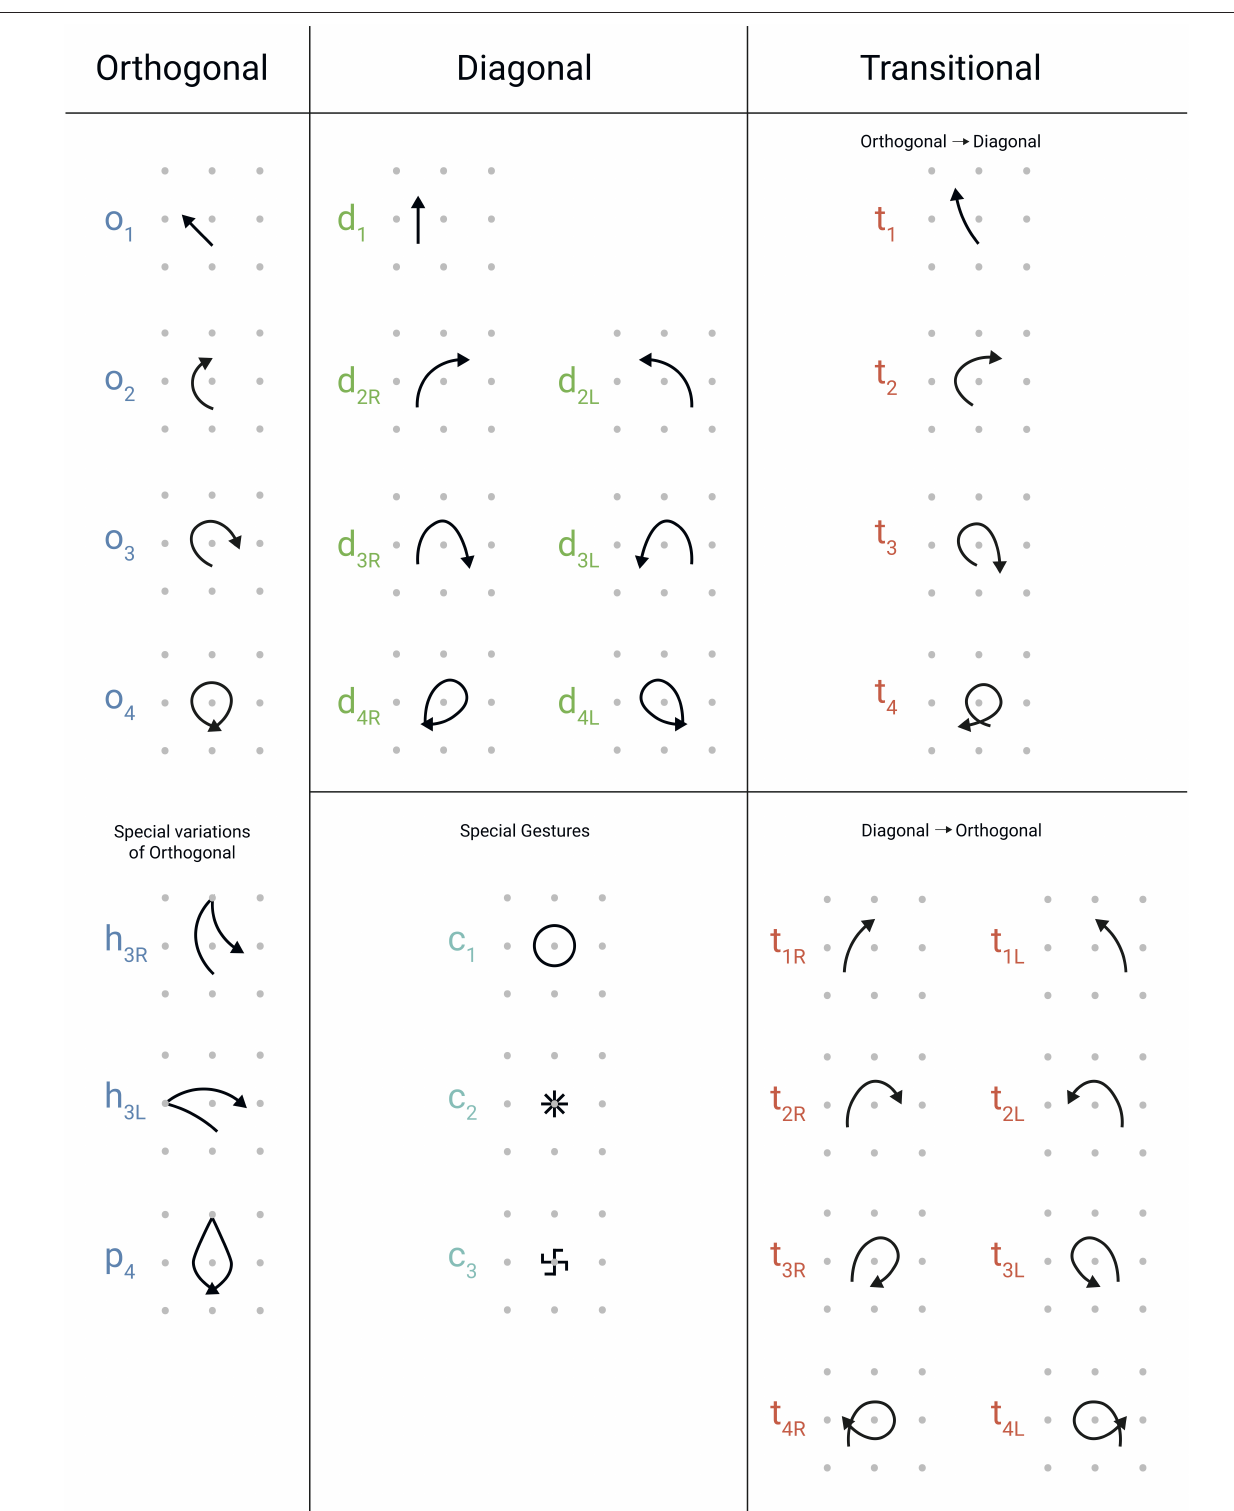
FIGURE 1 | The Lexicon of Kolam Gestures. This figure illustrates the gestures and the corresponding code to encode kolam drawings. Taken and adapted with permission from (Waring, 2012b).